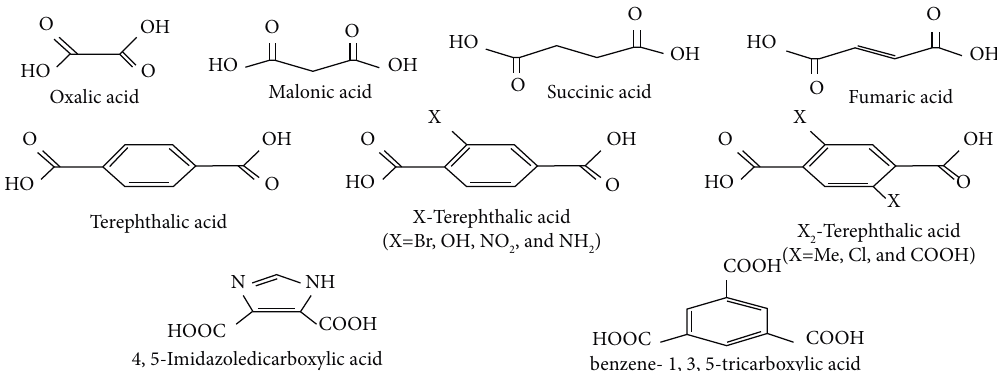
Figure 3: Organic linkers commonly used in building MOF structures are adopted from [25].